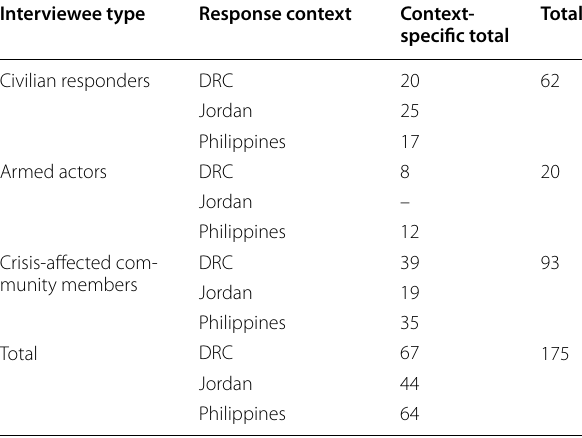
Table 1 Interviewees by type and